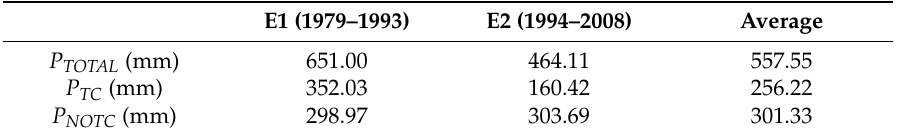
Table 2. The seven-station averaged P TOTAL , P TC , and P NOTC for P45–P50 (9 August–7 September) during E1 (1979–1993) and E2